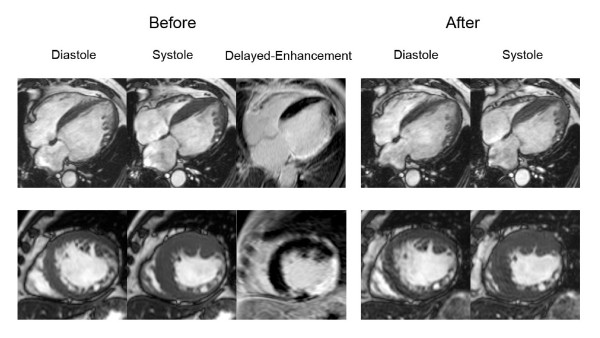
End-diastolic, end-systolic and LGE images before CABG and end-diastolic and end-systolic images after CABG of a patient with wall thinning and LGE area 76–100% in lateral wall displayed in 4-chamber (upper) and short-axis (lower) views.